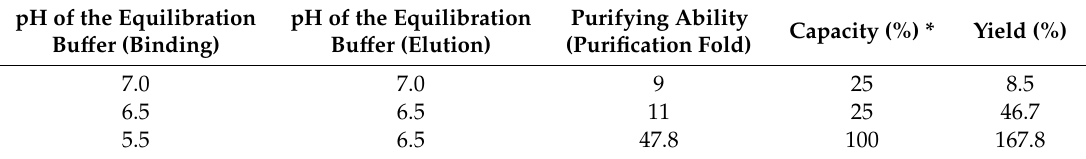
Table 3. The e ff ect of pH of the equilibration bu ff er on the chromatographic behavior (capacity, purifying ability and yield) of total protease activity on CB3GA-Cellulose-2 a ffi nity adsorbent. pH of the Equilibration pH of the Equilibration Bu ff er (Binding)